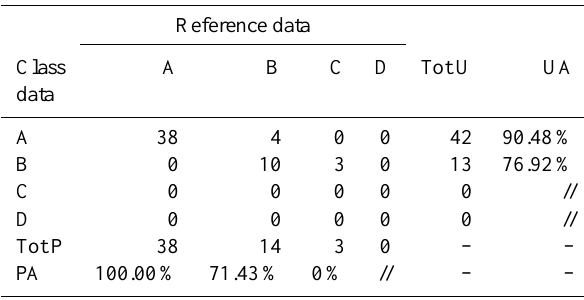
Table 5. Confusion matrix for the radial basis function network classifier evaluated on the test set TeS (cid:127) with elevation below 1000m; Class A: absence of snow cover, Class B: 1–10cm, Class C: 11–90cm, Class D: greater than 90cm.